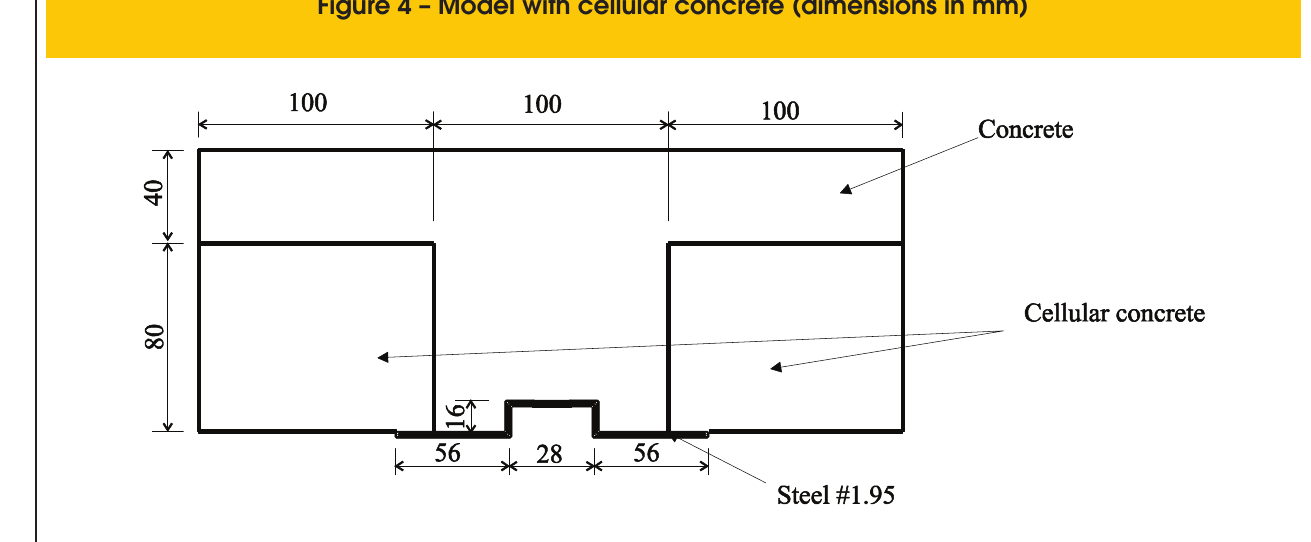
Figure 4 – Model with cellular concrete (dimensions in